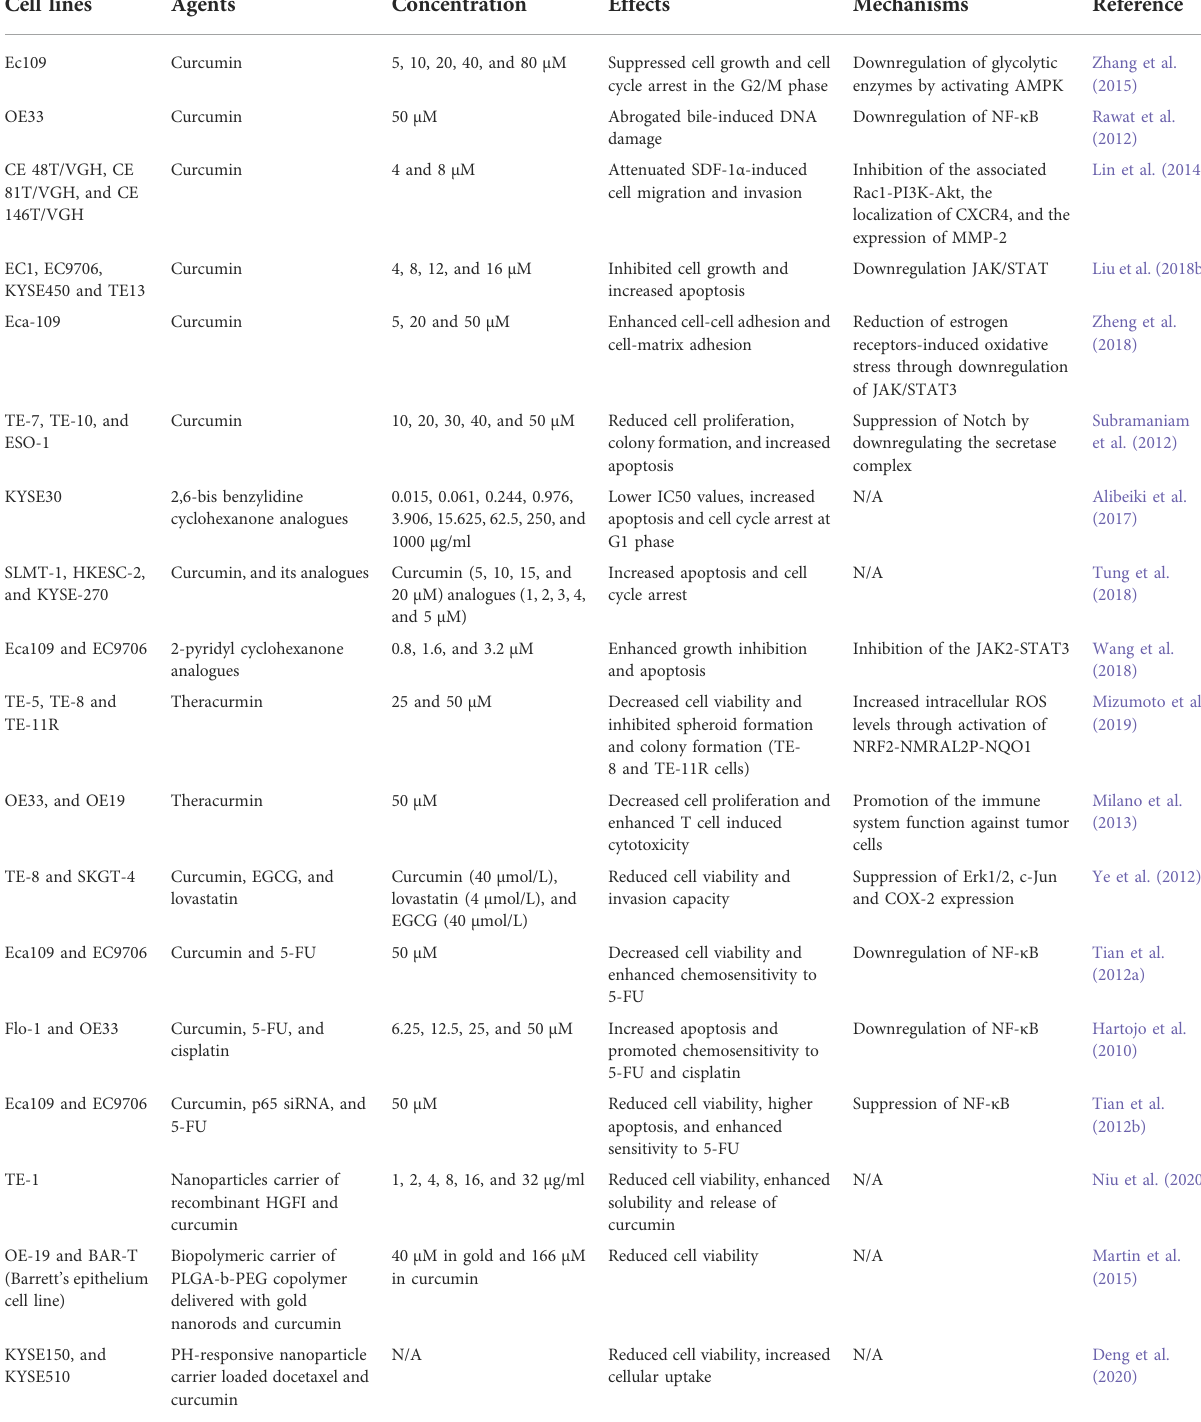
TABLE 1 In vitro studies for curcumin effects on